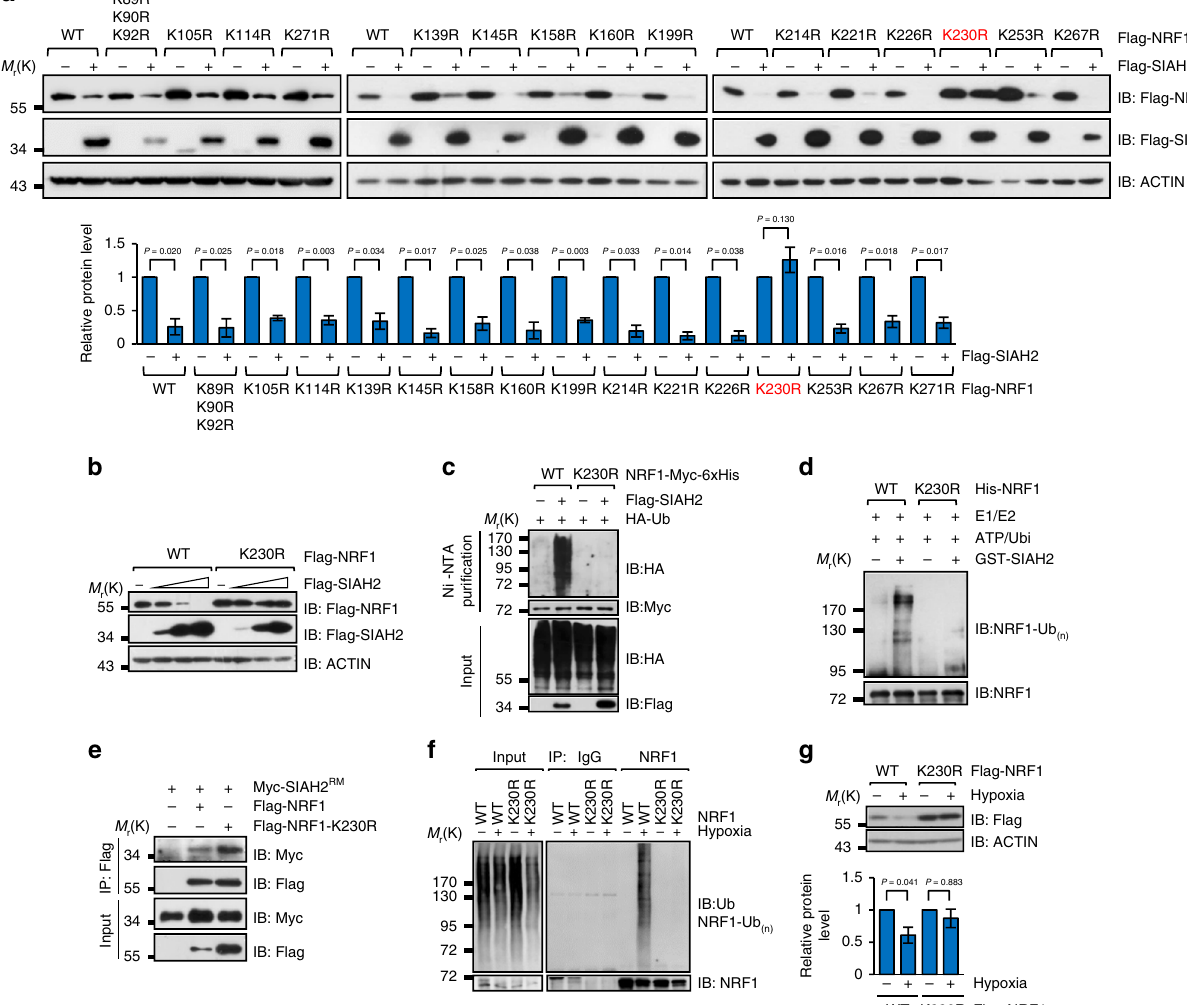
Fig. 4 NRF1 Lys230 is responsible for SIAH2-mediated NRF1 ubiquitination and degradation under hypoxia. a Determination of the Lysine 230 of NRF1 is responsible for SIAH2-induced degradation. Quanti fi cation of NRF1 protein levels is shown below. b SIAH2 induces degradation of wild-type NRF1 in a dosage-dependent manner but has no effect on NRF1-K230R. c SIAH2 induces ubiquitination of NRF1 but not NRF1-K230R. d Puri fi ed SIAH2 promotes ubiquitination of bacterially expressed wild-type NRF1 but not NRF1-K230R in vitro. e Co-immunoprecipitation of exogenously expressed Myc-NRF1 or Myc-NRF1-K230R with Flag-SIAH2 RM . f Hypoxia-induced ubiquitination of NRF1 is abolished by expression of the NRF1-K230R mutant in vivo. g HeLa cells were transiently transfected with wild-type NRF1 or NRF1-K230R for 12 h, and then incubated under normoxia or hypoxia for an additional 36 h. Cells were harvested and analyzed by immunoblotting with the indicated antibodies. Quanti fi cation of NRF1 protein levels is shown below. For all panels, error bars indicate s.d., n = 3 biological replicates. Data were compared with two-tailed paired ratio t